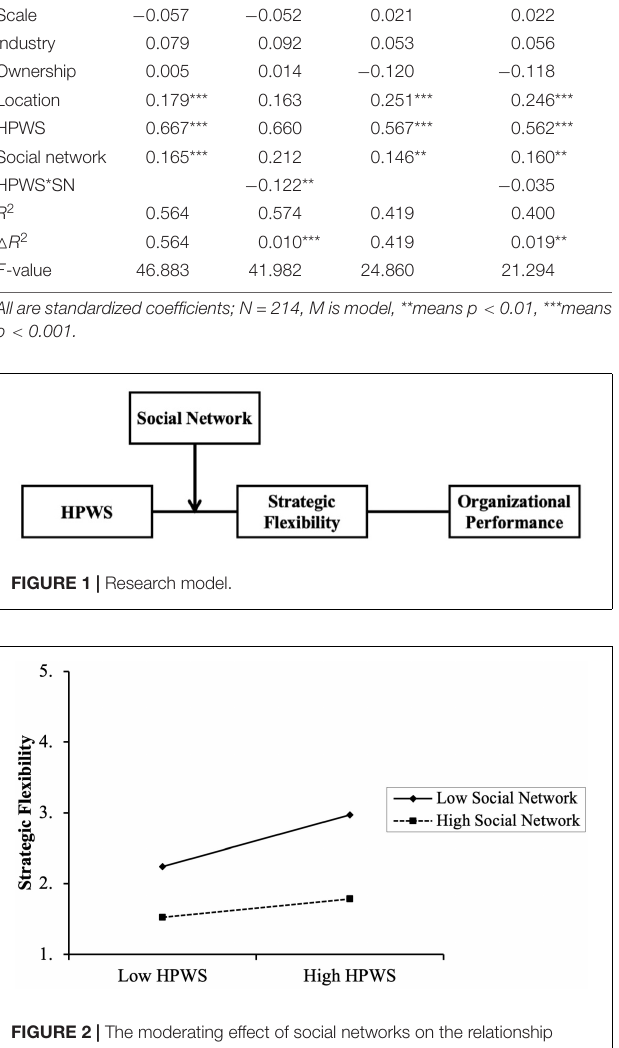
FIGURE 2 | The moderating effect of social networks on the relationship between HPWS and strategic